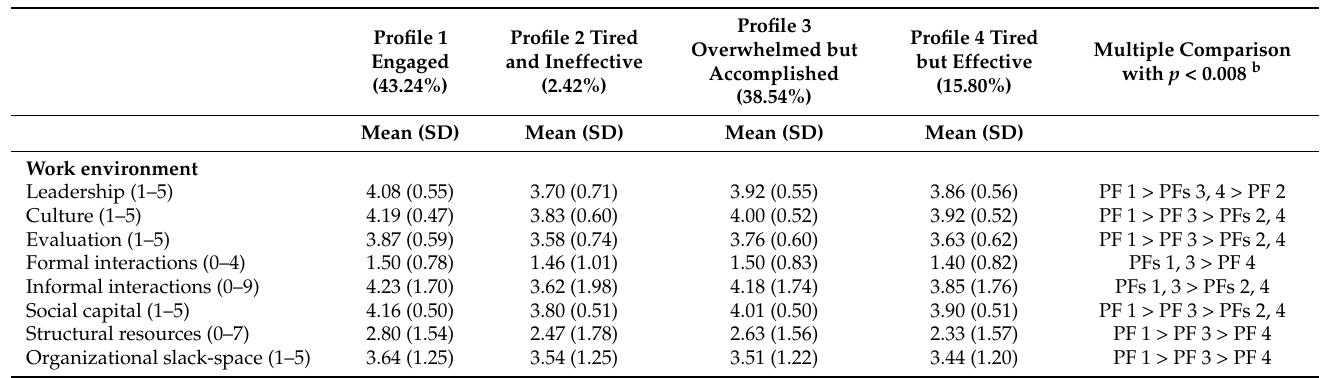
Table 4. Perceptions of work environment, experiences of work-life, and health status by profile membership ( n = 3765) a